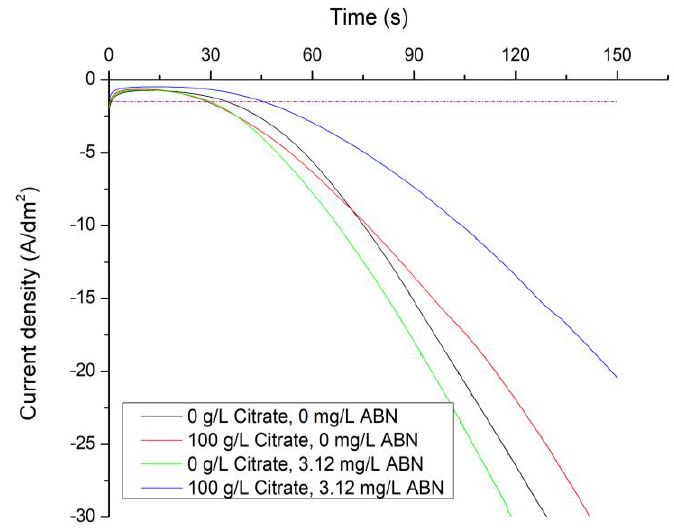
Figure 9. Current density transients in MSA electrolyte at − 0.65V. Horizontal line marks current density of − 1.5 A/dm 2 at which dendritic layers from citrate and ABN free electrolyte were deposited.